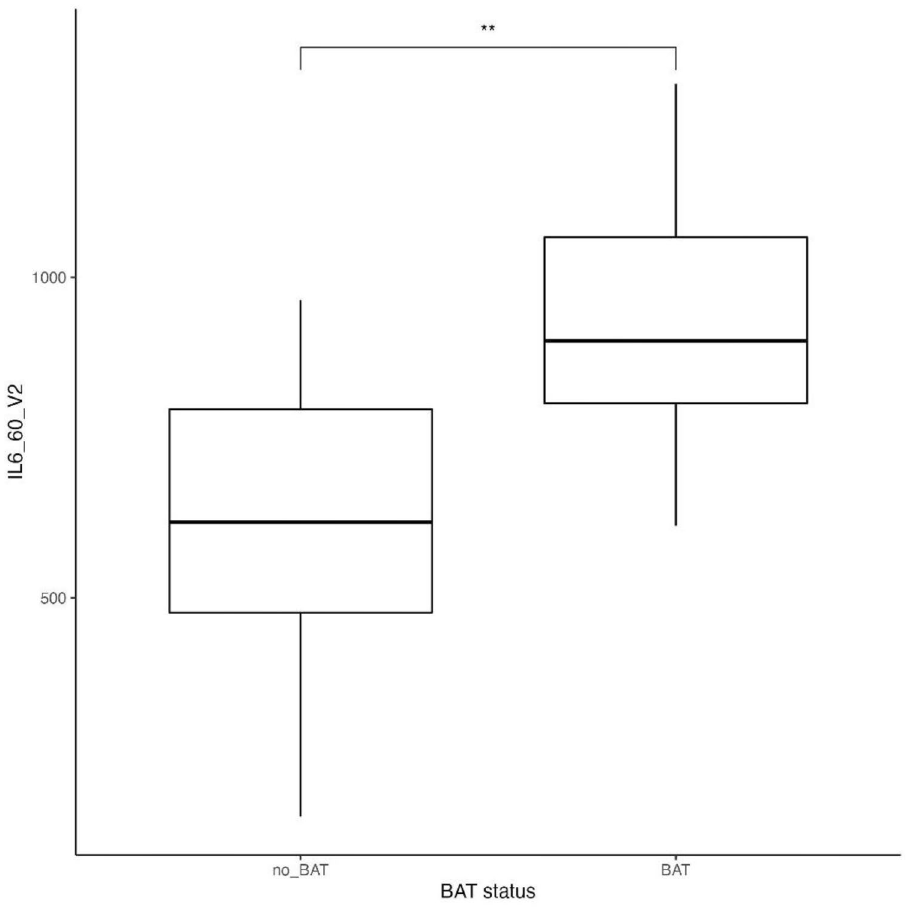
Figure 5. IL-6 concentration in serum during cold exposure in subjects dependently on BAT status (p =